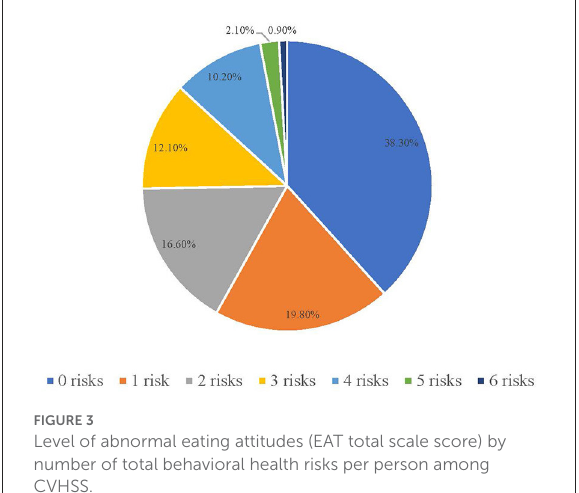
FIGURE3 Level of abnormal eating attitudes (EAT total scale score) by number of total behavioral health risks per person among